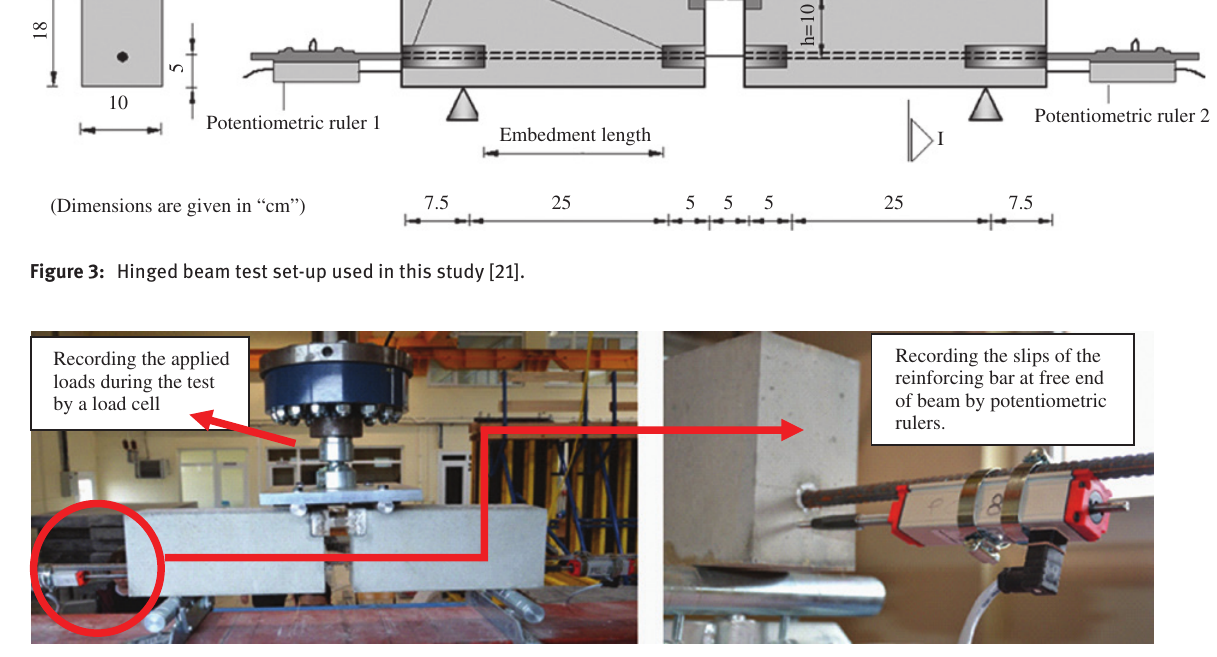
Figure 4: Details of the experimental test set-up used in this research.